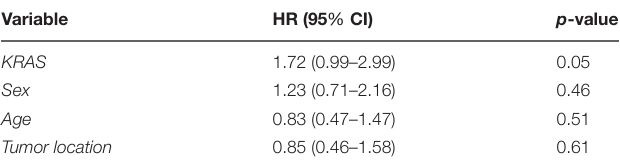
TABLE 4 | Multivariate